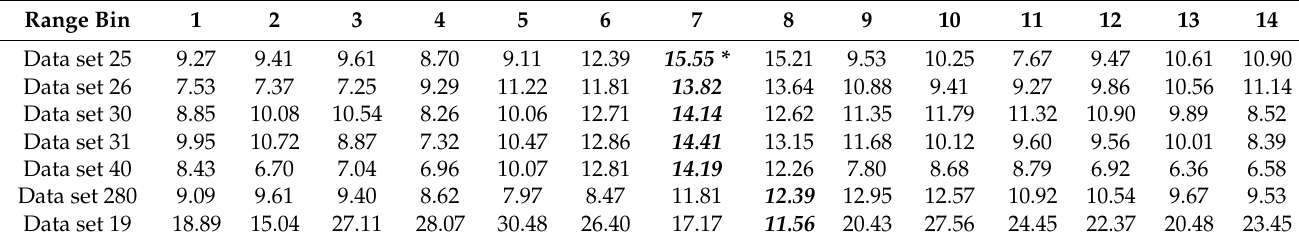
( MSE ) of data sets 25, 26, 30, 31, 40, 280, and hh / MSE vv col